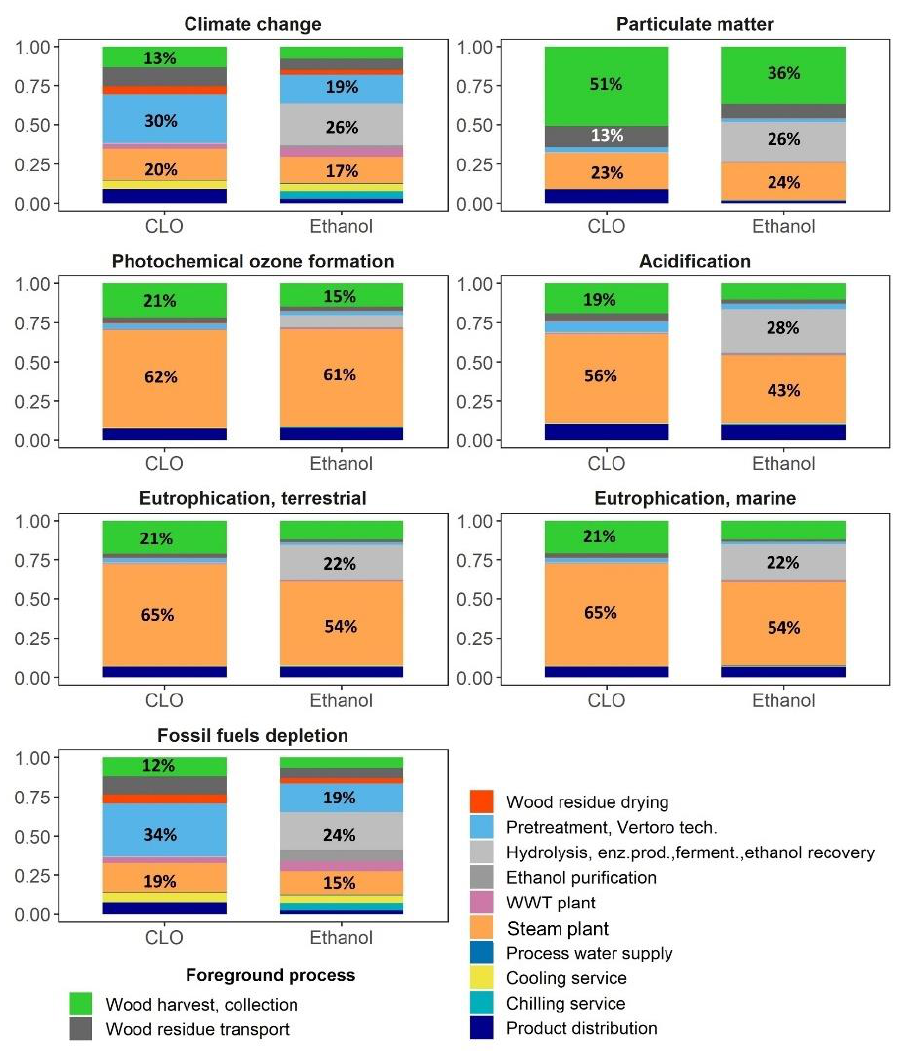
Figure 5. Foreground processes contribution analysis.